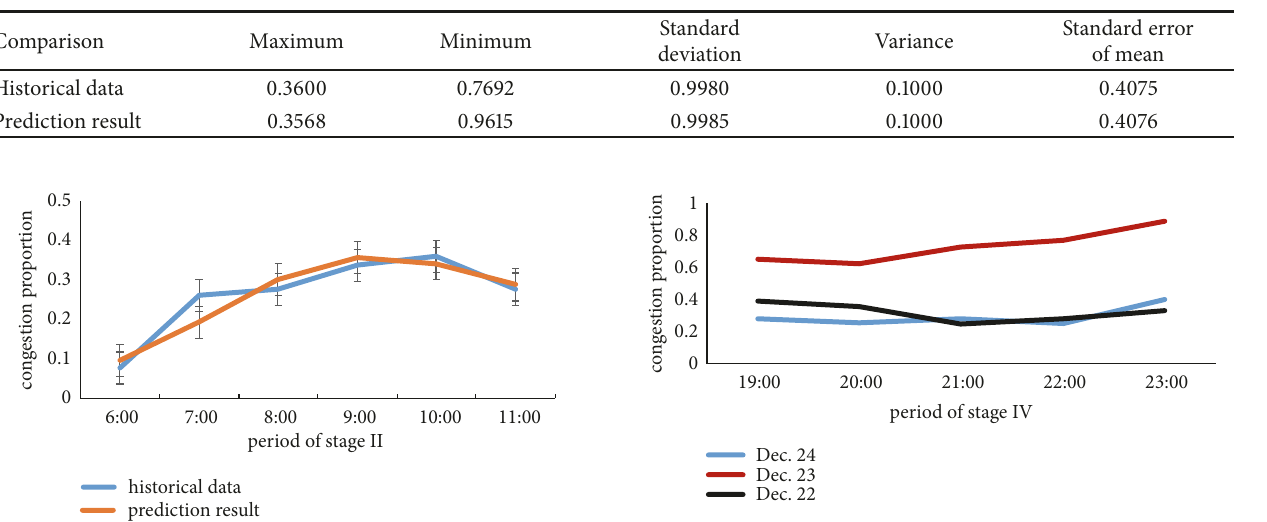
Table 2: Descriptions of historical data and prediction result on stage II.